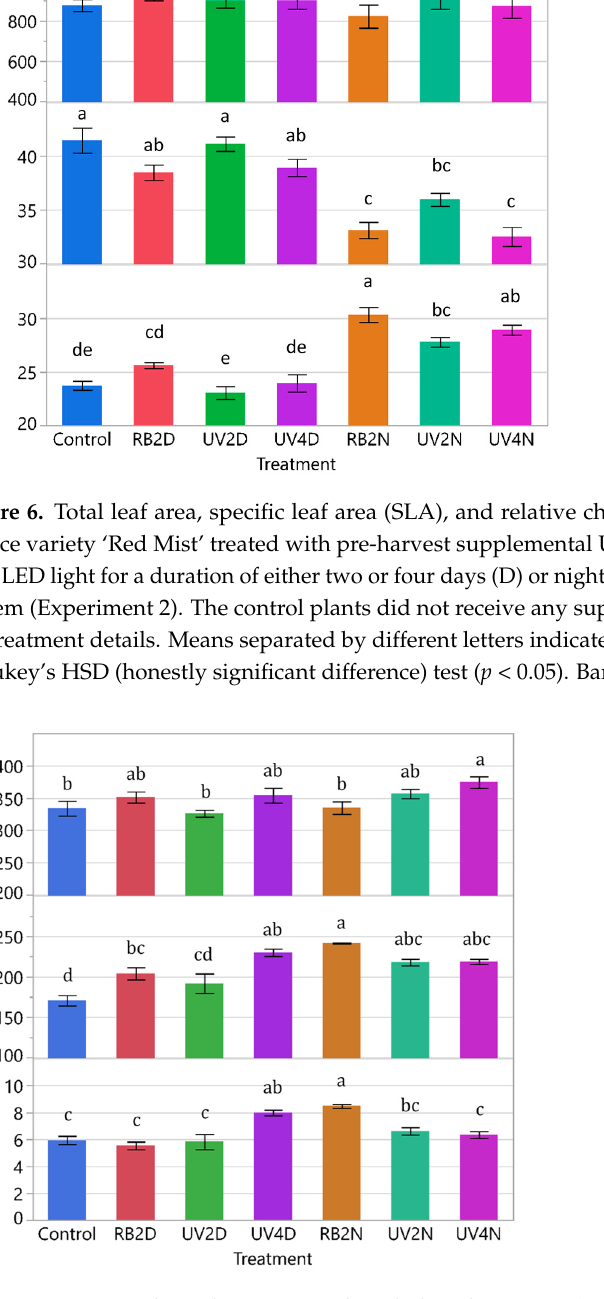
Figure 7. Carotenoids, anthocyanin, and total phenolic content (TPC) of leaf tissue samples from the lettuce variety ‘Red Mist’ treated with pre-harvest supplemental UV-A/Blue (UV) or Red and Blue (RB) LED light for a duration of either two or four days (D) or nights (N), in a greenhouse hydroponic system (Experiment 2). The control plants did not receive any supplemental LED light. See Table 2 for treatment details. Means separated by different letters indicate significant differences according to Tukey’s HSD (honestly significant difference) test ( p < 0.05). Bars represent standard error.